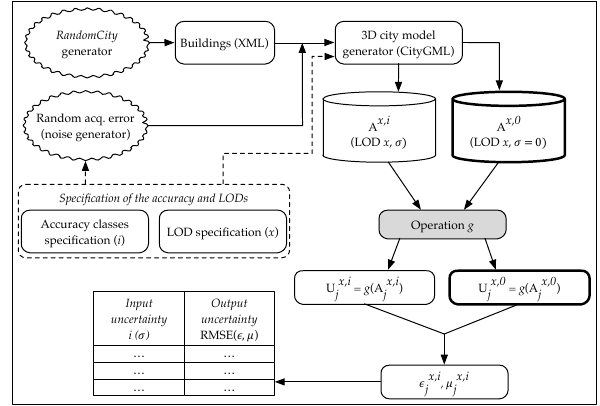
Figure 1: The diagram of the presented methodology. The GIS operation is shown in grey, and the ground truth elements are out- lined with thicker strokes. The terms and notations are explained throughout the Section